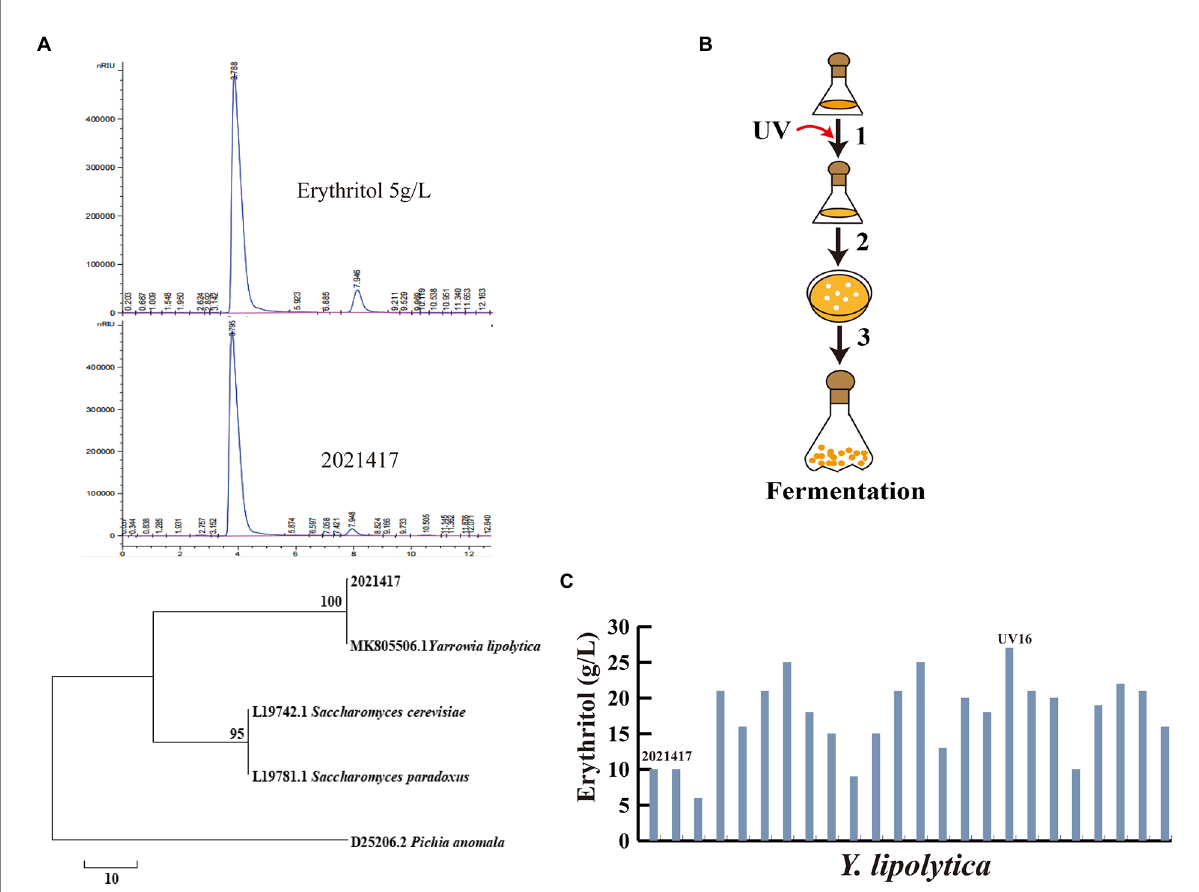
FIGURE 1 Identification and screening of mutant strains for erythritol production. (A) HPLC and phylogenetic tree of 2,021,417. (B) UV mutagenesis and mutant screening flowchart. 1: UV mutagenesis; 2: Growth of surviving cells on YPD plates; 3: Fermentation of strains obtained by mutagenesis. (C) Erythritol titers after UV mutagenesis. Three biological replicates were used to obtain the data. The error bars represented the standard